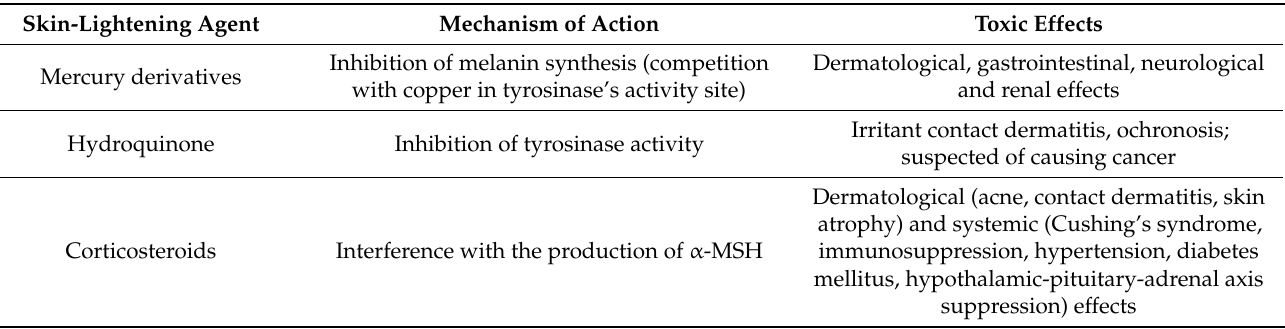
Table 2. Mechanisms of action and toxic effects of the banned depigmenting agents